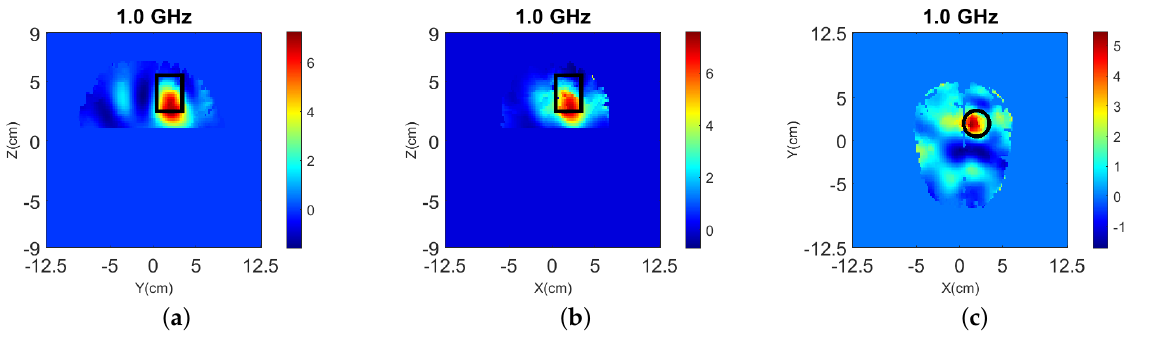
Figure 5. 3-D reconstructions with simplified Green’s functions for “Case I” of Figure 2 at 1.0 GHz. ( a – c ) Relative permittivity (cid:60) ( ε r ) , and ( d – f ) contrast (cid:60) ( δ ε ) for the y-z, x-z, and x-y slices, respectively. A cylindrical eight-antenna array centered at the target height is used to produce the data.